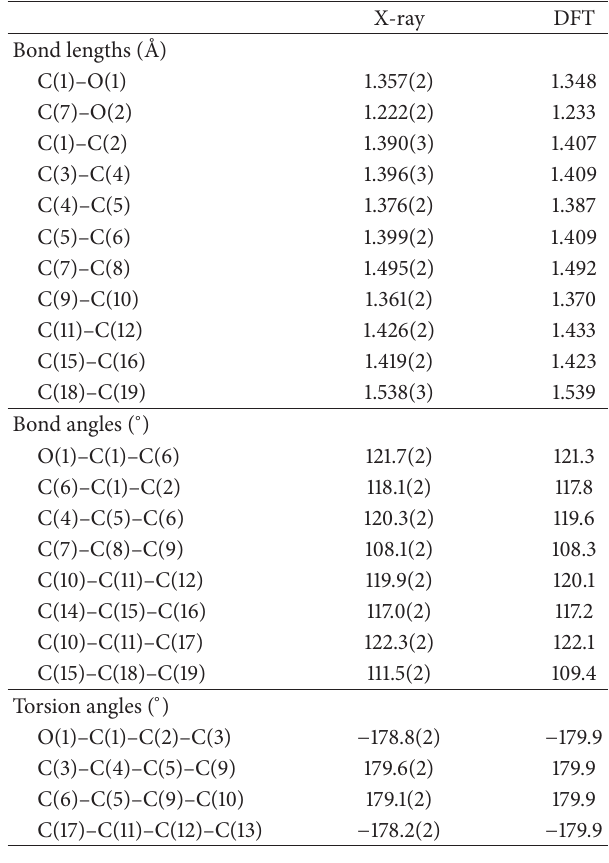
Table 1: Comparison of the experimental and optimized geometric parameters of 1